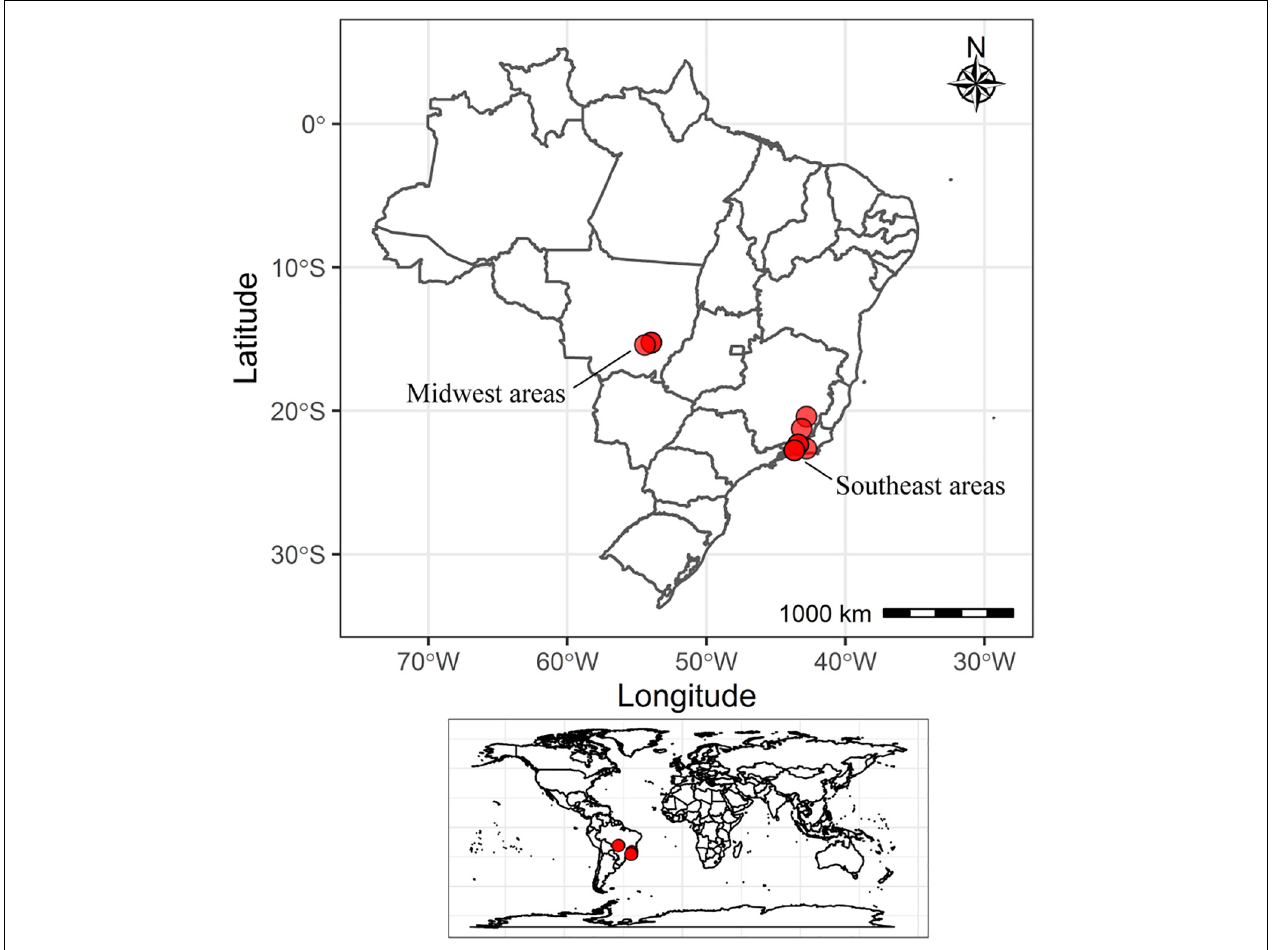
FIGURE 1 | Map of Brazil with the locations of soil sample collection